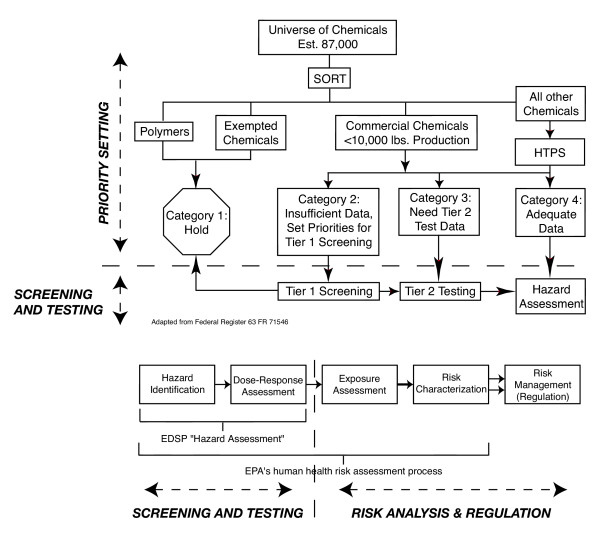
EDSP policy design